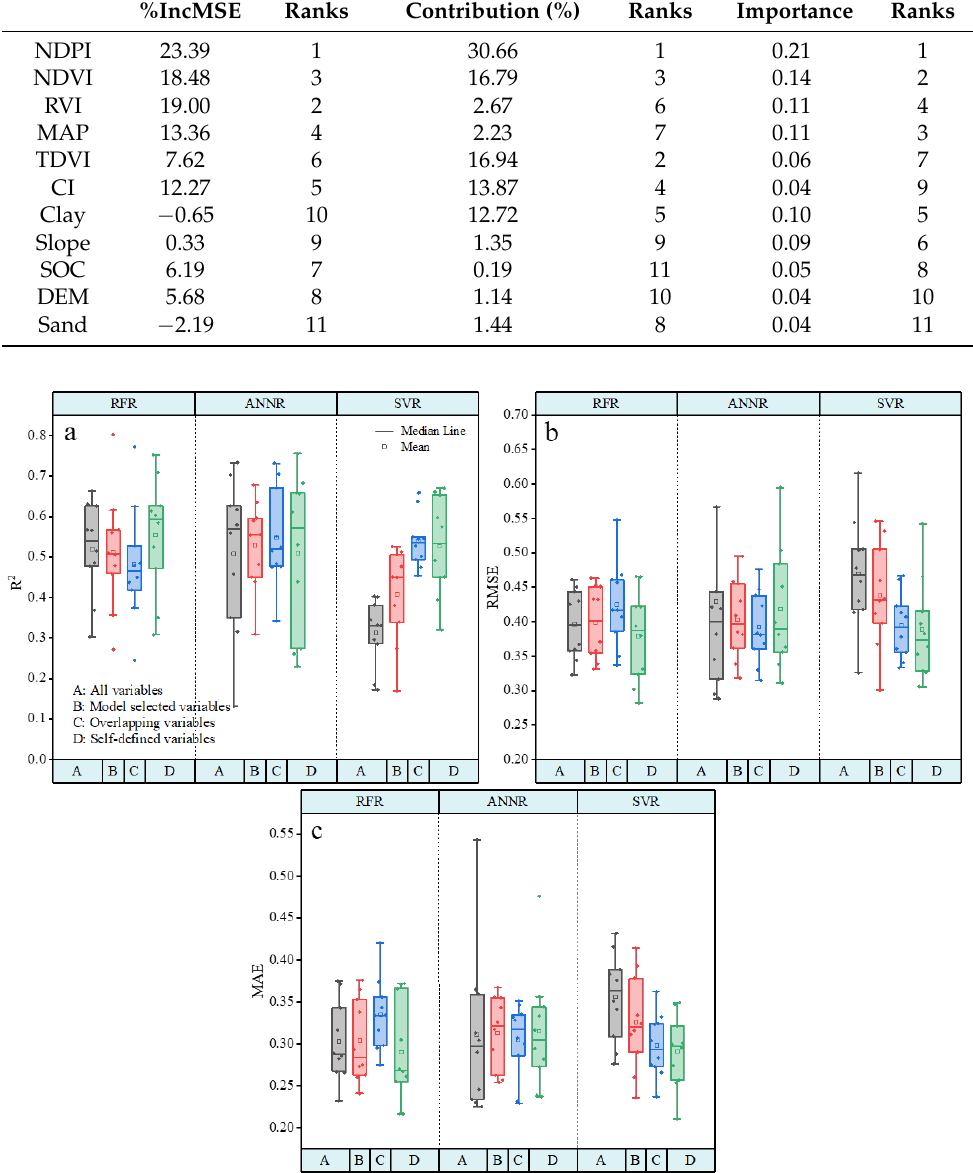
Figure 5. The box plot of the validated ( a ) R 2 , ( b ) RMSE, and ( c ) MAE values of the 10-fold cross validation for each machine learning regression algorithm under four modeling scenarios.